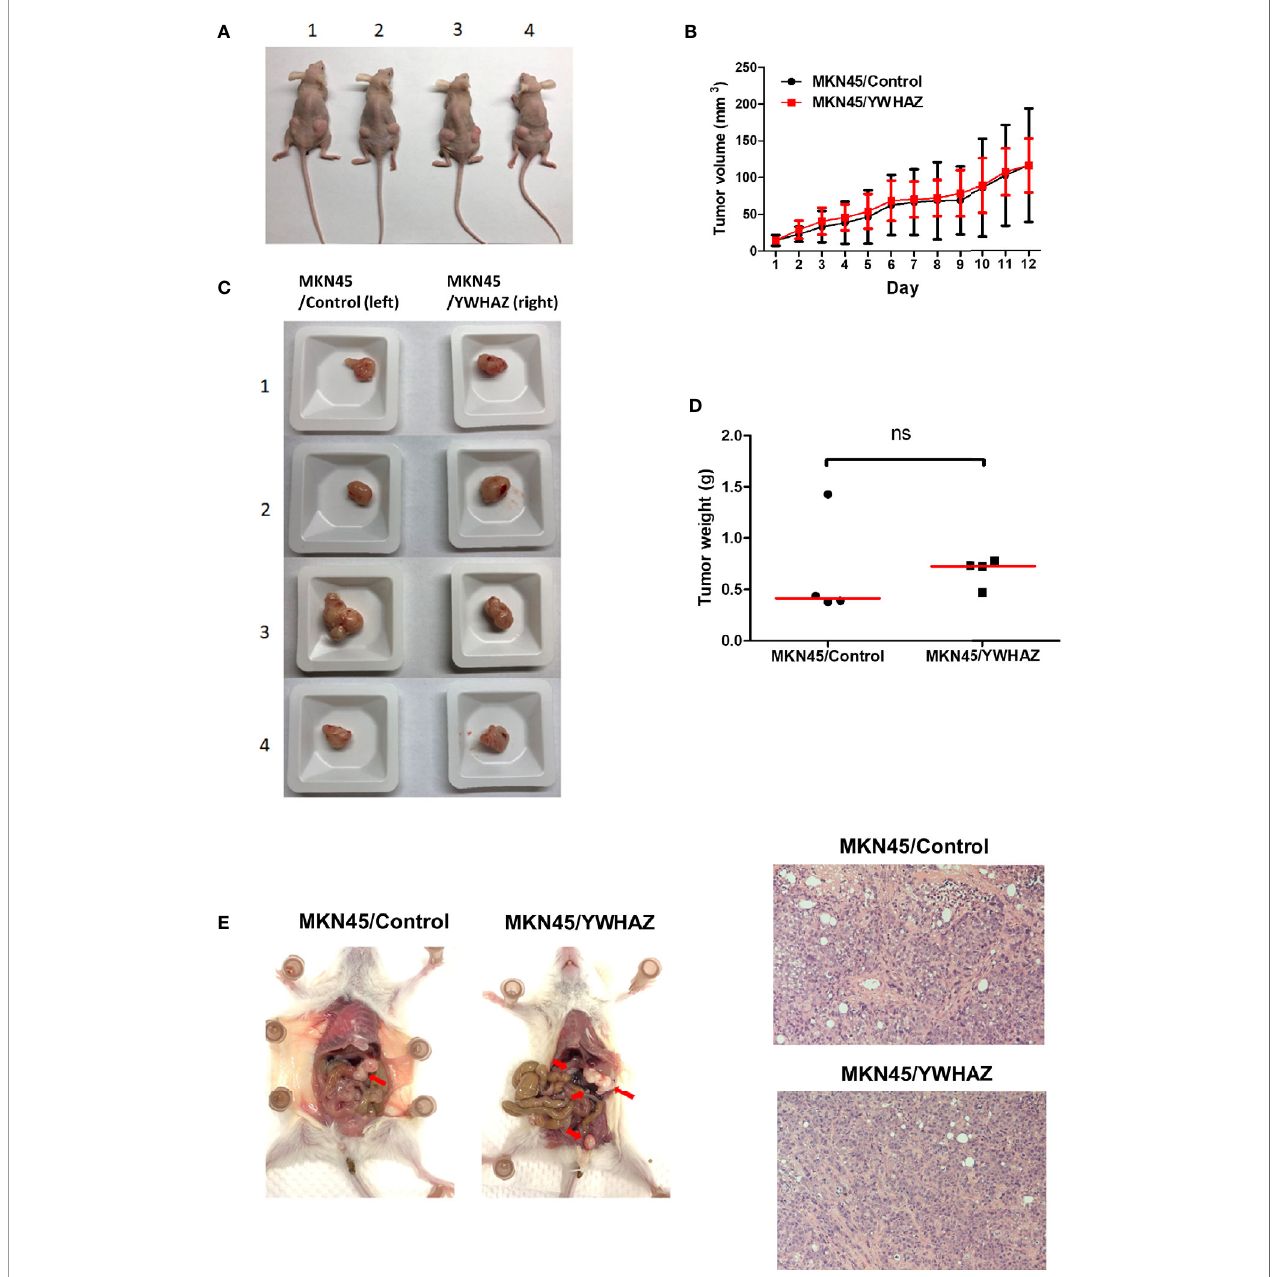
FIGURE 5 | YWHAZ enhanced metastasis in MKN45 cells in vivo . MKN45 cells transfected with control (MKN45/Control) or plasmid expressing YWHAZ (MKN45/ YWHAZ) were injected subcutaneously (s.c.) into nude mice (A – D) or intraperitoneally into NOD-SCID mice (E) . (A) Representative images showing the tumor in an s.c. xenograft mouse model. Overexpression of YWHAZ demonstrated a similar tumor size (B, C) and weight (D) of the xenograft, as compared to control. (E) However, MKN45/YWHAZ cells demonstrated more intraperitoneal nodules (red arrow) as compared to control, after 5 weeks of injection (red arrow). H&E stain presented tumor cells obtained from the liver of NOD-SCID